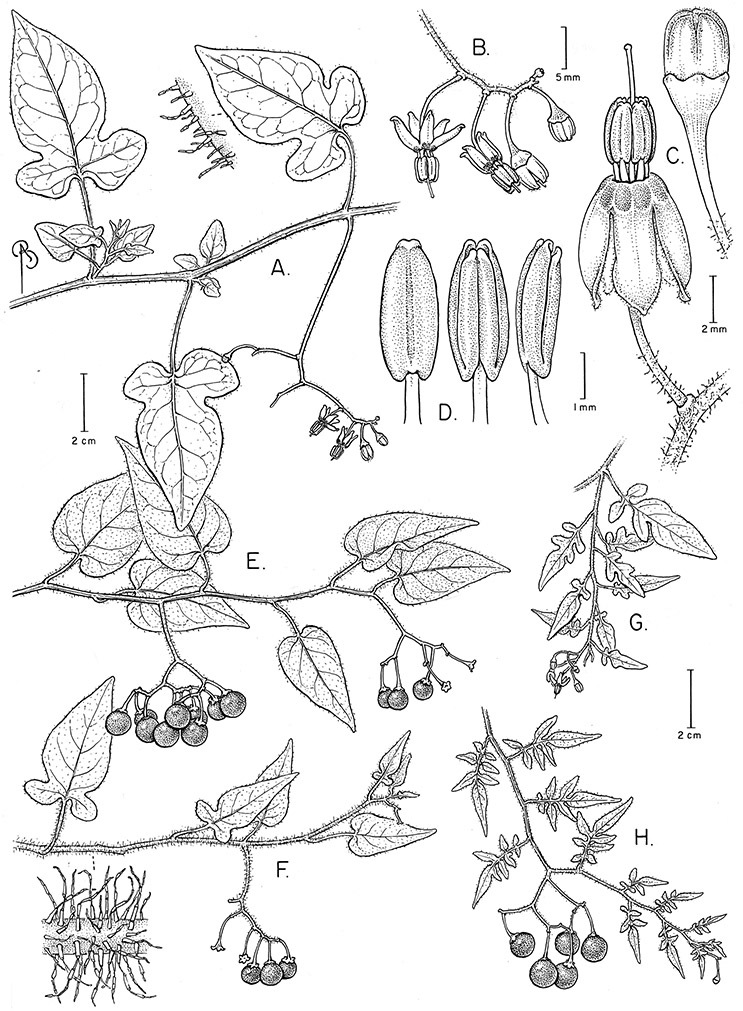
Solanum lyratum Thunb. (A–D drawn from Smith 6432 and Knapp 10142
E–G drawn from Peixing Tan 57179
G drawn from Smith 2265
H drawn from Junsheng Ying 0907). Illustration by Bobbi Angell.